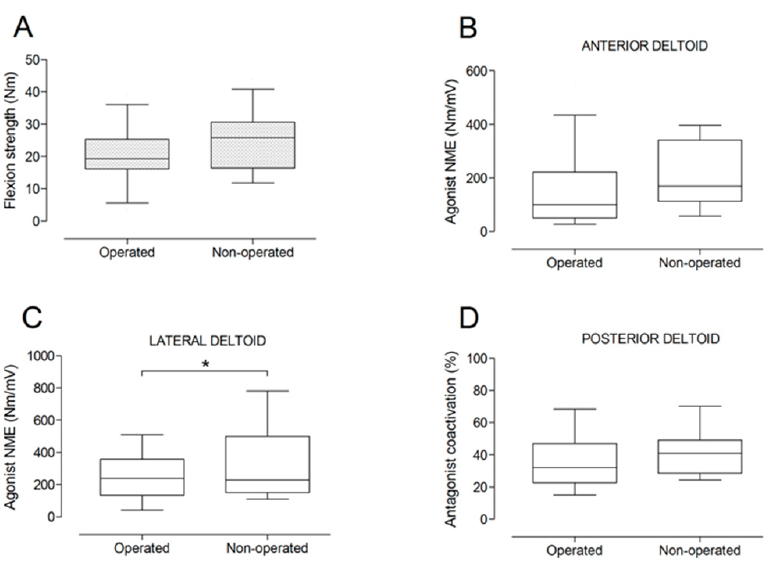
Figure 6. Box and whisker plots of shoulder flexion strength ( A ), agonist neuromuscular e ffi ciency (NME) of anterior deltoid ( B ) and lateral deltoid ( C ) muscles, and antagonist coactivation of posterior deltoid muscle ( D ) by side. The horizontal line in the box represents the median, the height of the box represents the interquartile range, and the distance between the opposite ends of the whisker represents the 10th–90th percentile. *Operated < non-operated ( p < 0.05).